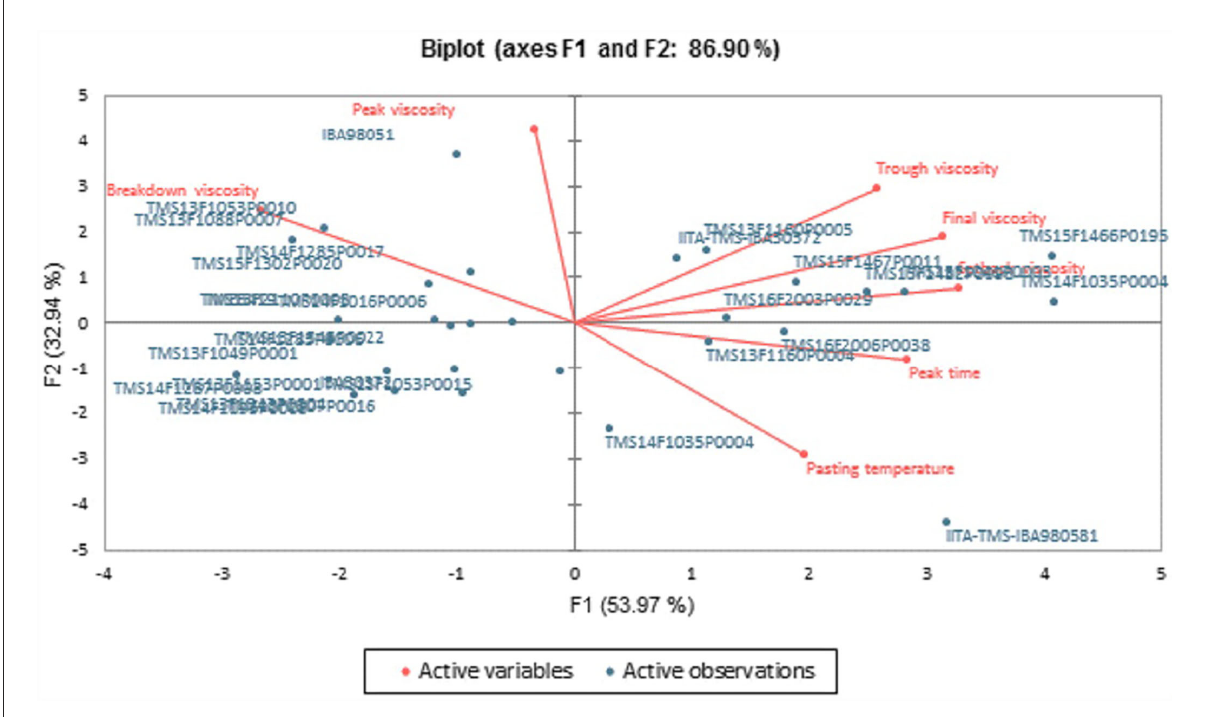
FIGURE2 The principal component analysis biplot of the pasting properties of gari